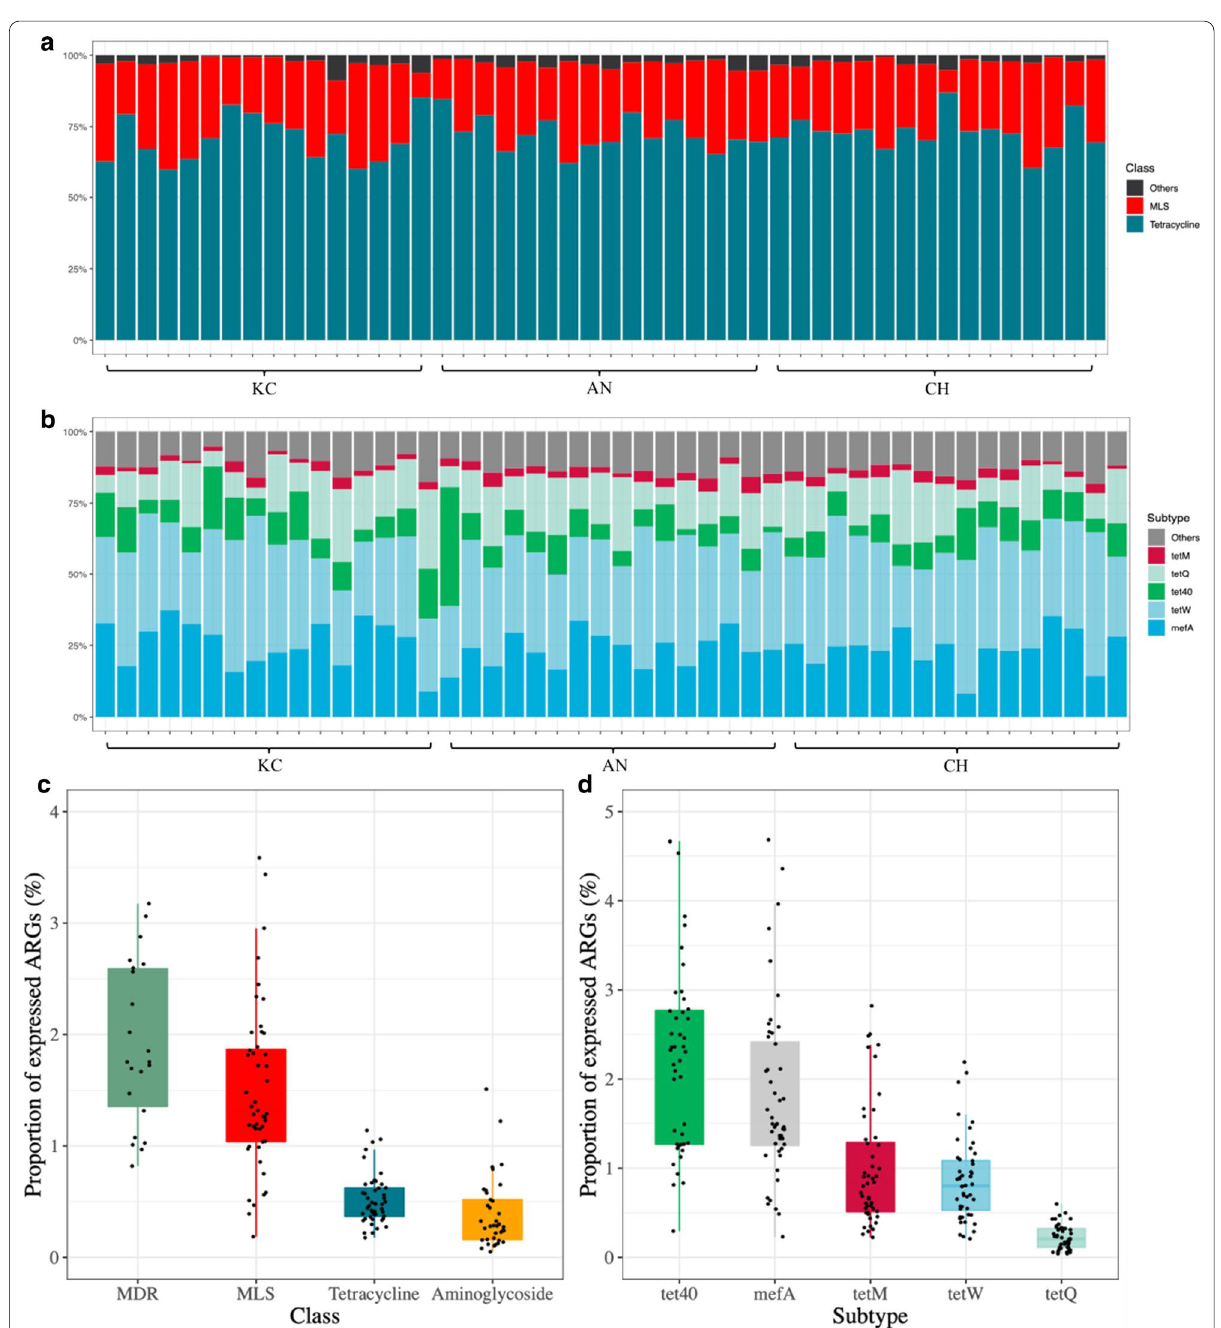
Fig. 2 Profiles of active resistome in the rumen of 48 beef cattle. a The active rumen resistome is predominant by ARGs belonging to tetracycline and MLS classes, and ‘others’ include other 8 classes. b Proportion of 5 predominant expressed ARGs and ‘others’ include other 55 individual expressed ARGs. c Proportion of major expressed ARG classes. d Proportion of major expressed ARGs. ARG, antimicrobial resistant gene; MDR, multidrug; MLS,